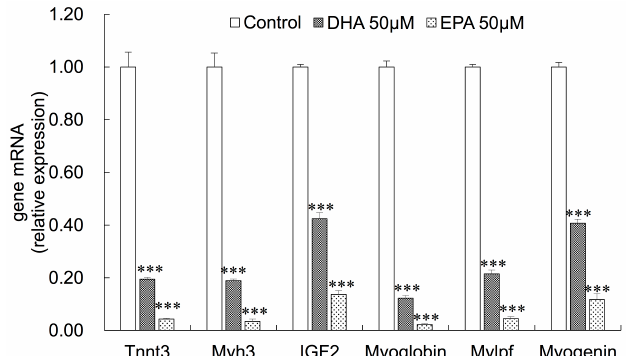
Figure 5. qRT-PCR results of selected genes. The data represent the mean ± S.D. from three independent experiments performed in duplicate. Different from control, *** p < 0.001.